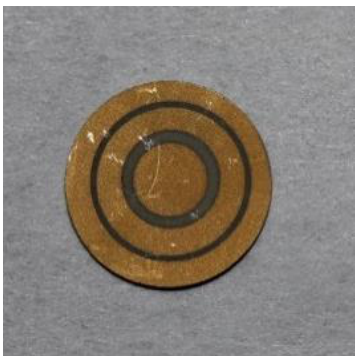
wafer is designed to enhance the third radial mode. Table 1. Polarization and dimensions of the non-uniformly poled piezoelectric wafer.